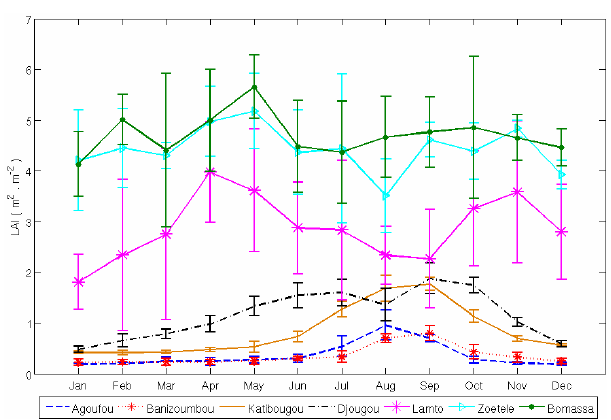
Fig. 2. Monthly variation of MODIS LAI averaged over the period 2000-2007 for IDAF sites. Vertical bars depict the standard deviation over the study period.